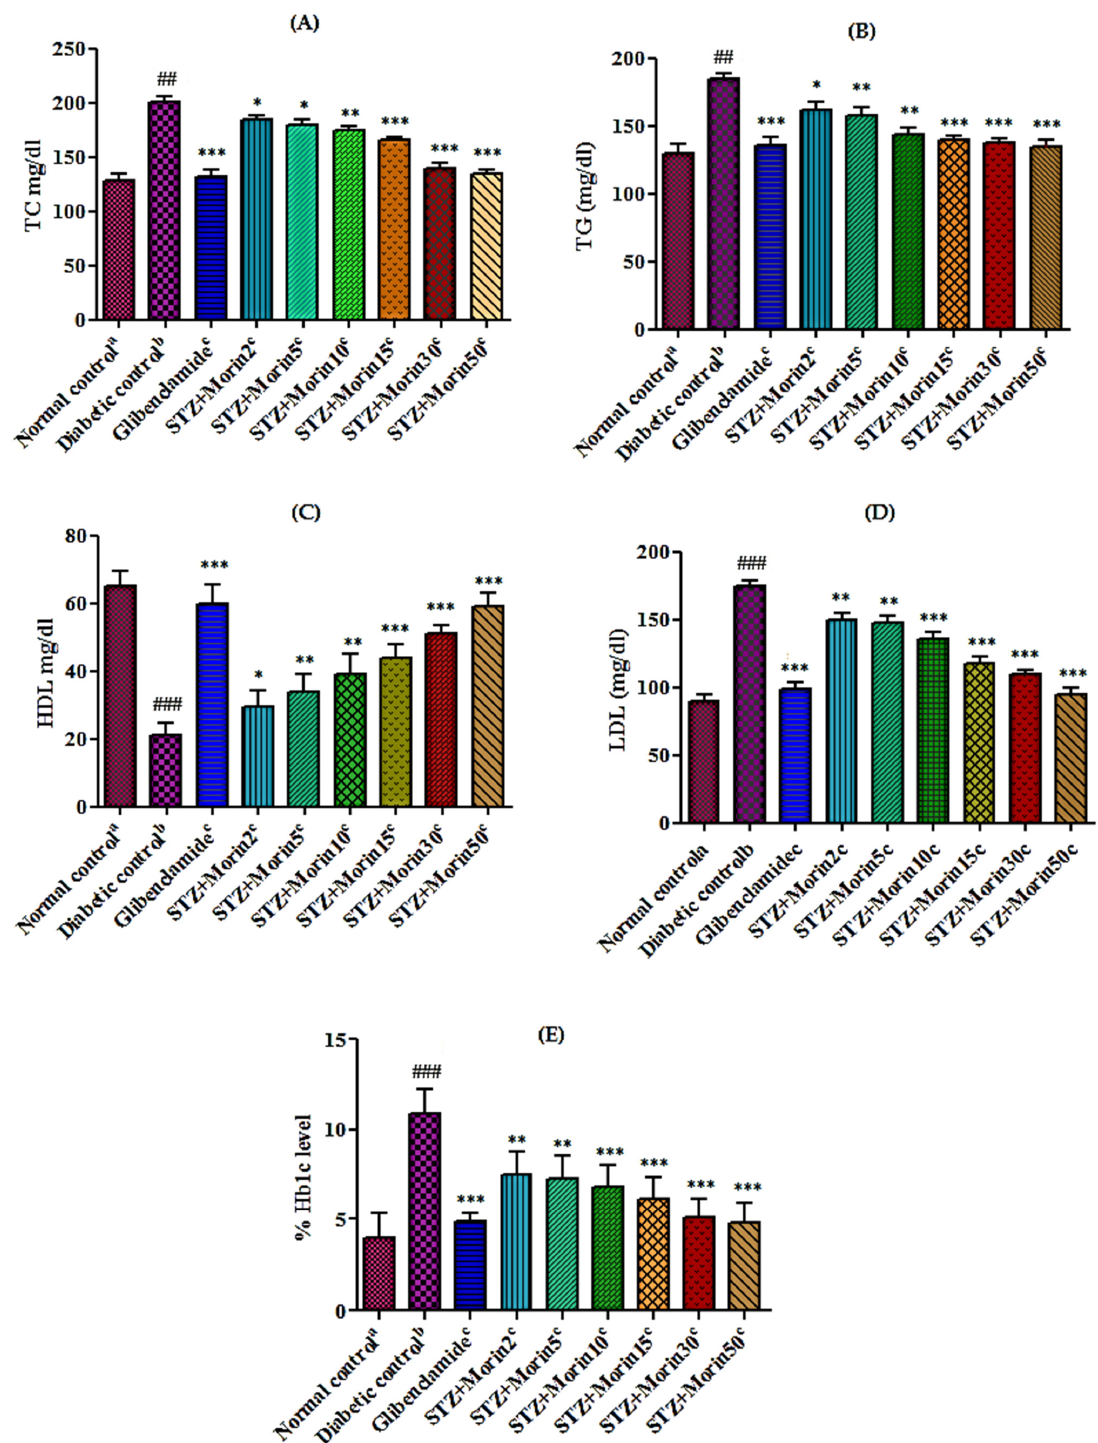
Figure 4. Effect of morin on lipid profile and Hb1c level in streptozotocin induced diabetic rats. [( A )TC level, ( B ) TG level, ( C ) HDL level, and ( D ) LDL level, ( E ) Hb1c level. The values are expressed as mean ± SEM. Each value corresponds to a mean of eight animals ## p < 0.01; ### p < 0.001; comparison of normal control a vs. diabetic control b using Student’s T -test, * p < 0.05, ** p < 0.01, *** p < 0.001; comparison of diabetic control b vs. glibenclamide c and morin c treated groups using one way ANOVA followed by Dunnett’s post hoc multiple comparison